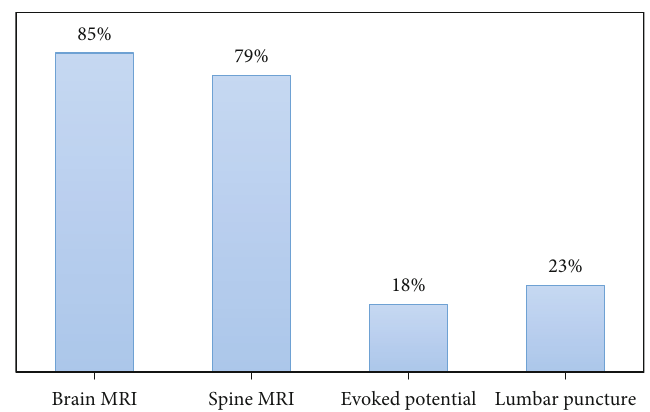
Figure 1: Diagnostic tests among individuals with pediatric onset of MS ( n = 287 ).